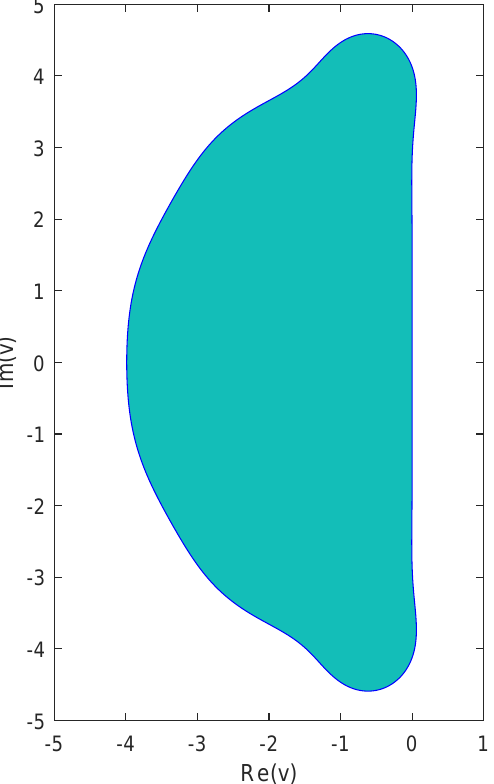
Figure 1. Stability region of the new Runge–Kutta method of Table